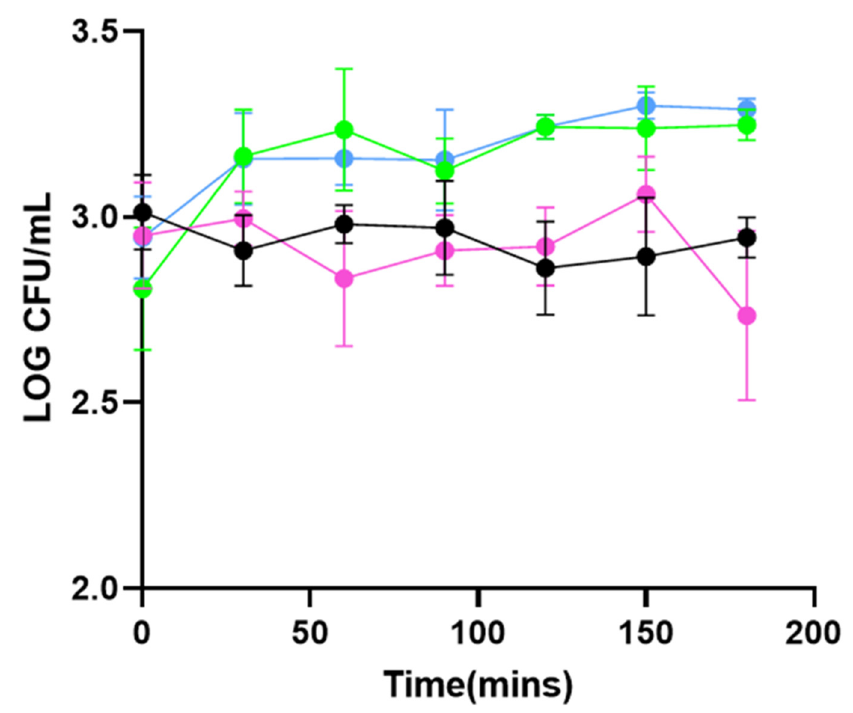
Figure 3. Experiment 2B: growth inhibition assays at 22 ◦ C using 1 × 10 3 CFU/mL L. monocytogenes 473 (serotype 4e). L. monocytogenes strain 473 was inoculated into TSB containing PHA_lysin293_BNPs (pink symbols) ( n = 4), PHA_amidase293_BNPs (black symbols) ( n = 4), L. mono + PHA_BNP control (green symbols) ( n = 4), and L. mono-PHA_BNPs (blue symbols) ( n = 4). Cells were incubated at 22 ◦ C and samples taken for plating on Listeria Chromogenic Agar at 0, 30, 60, 90, 120, 150 and 180 min. The figure depicts total counts of L. monocytogenes.